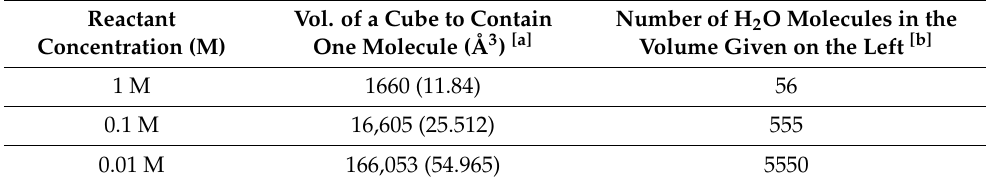
Table 4. The volume of a cube to contain one particle at various concentrations and the number of water molecules to fill the same cube. Reactant Vol. of a Cube to Contain Number of H 2 O Molecules in the Concentration (M) One Molecule (Å 3 ) [a] Volume Given on the Left